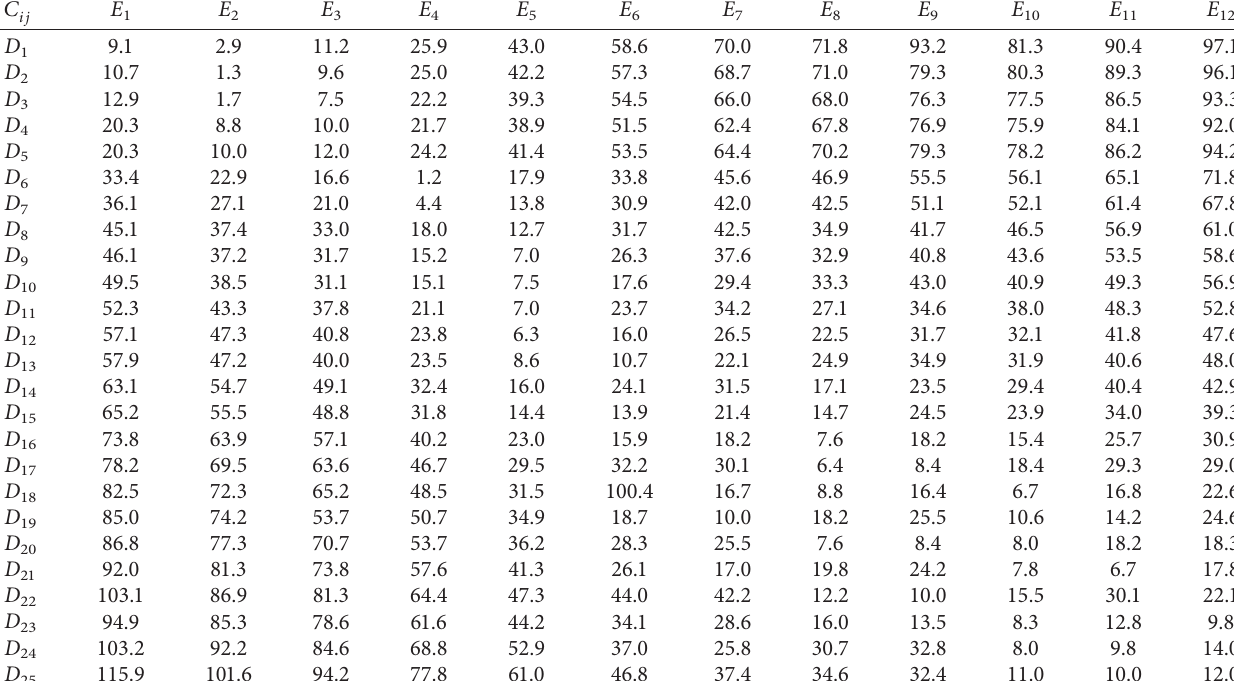
Table 6: Unit transportation cost between various